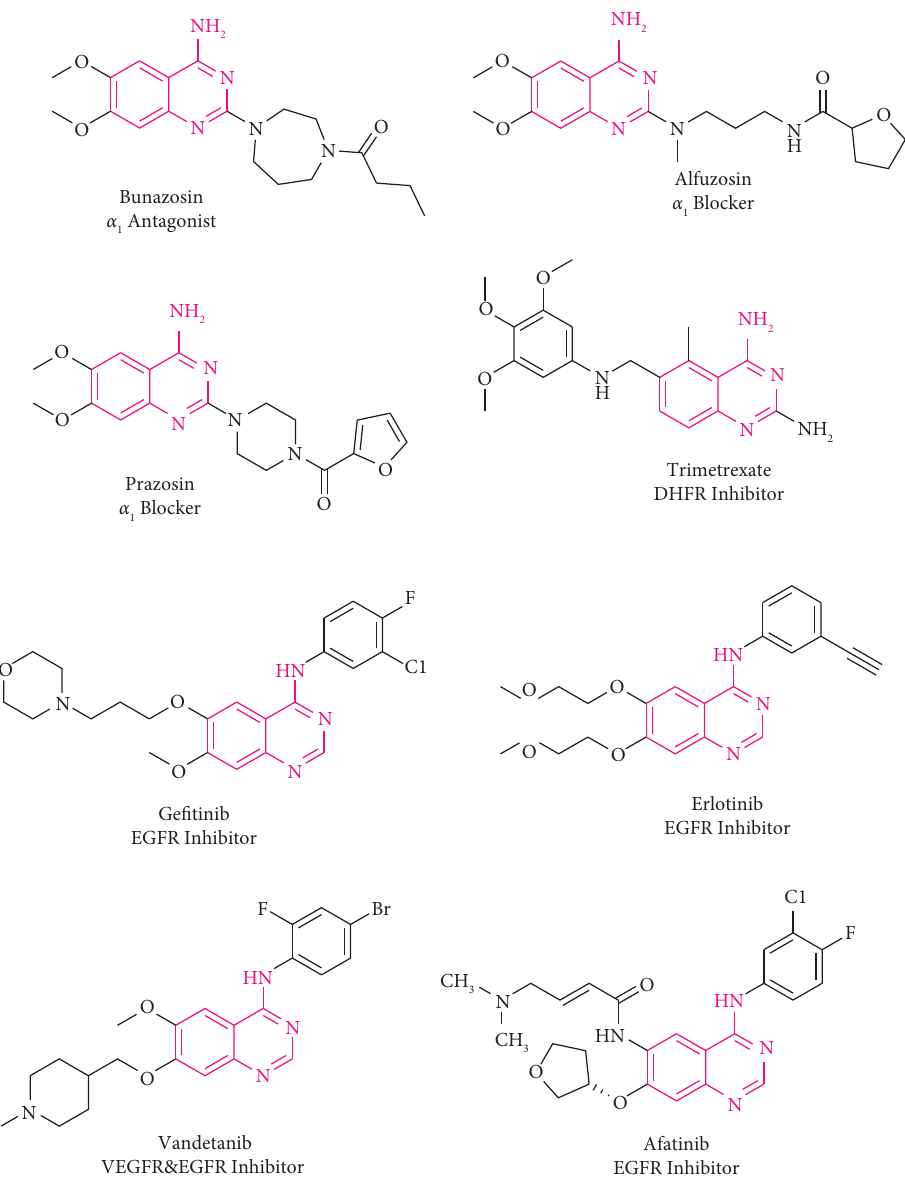
Figure 2: 4-aminoquinazoline-based